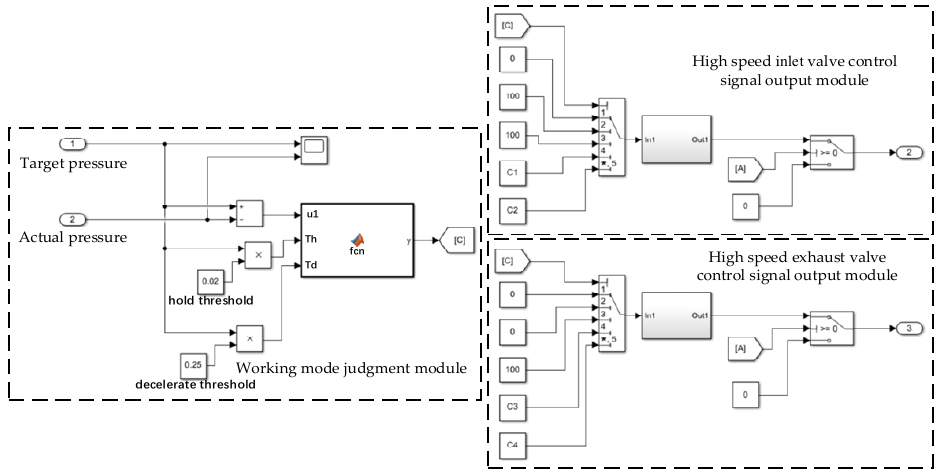
Figure 4. The MATLAB/Simulink model of dynamic PWM coupling pressure regulation method.